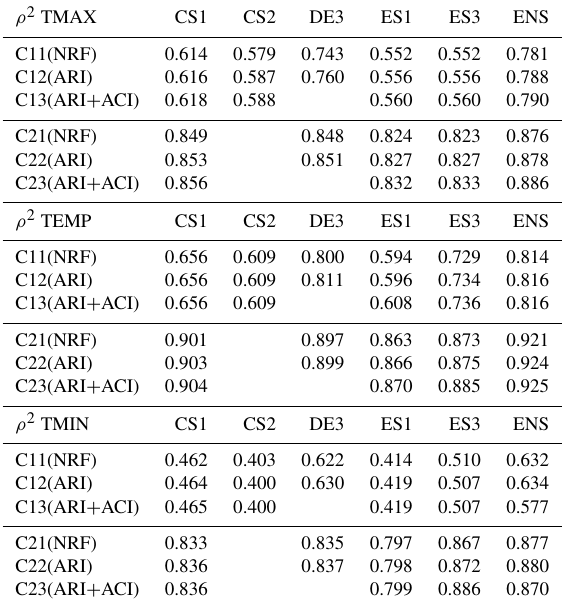
Table 5. Coefficient of determination ( ρ 2 ) in those areas affected by high aerosol optical depths (1h AOD > 1.0 for the fires, C1X case, and AOD > 0.5 for the dust, C2X case) with respect to the E-OBS